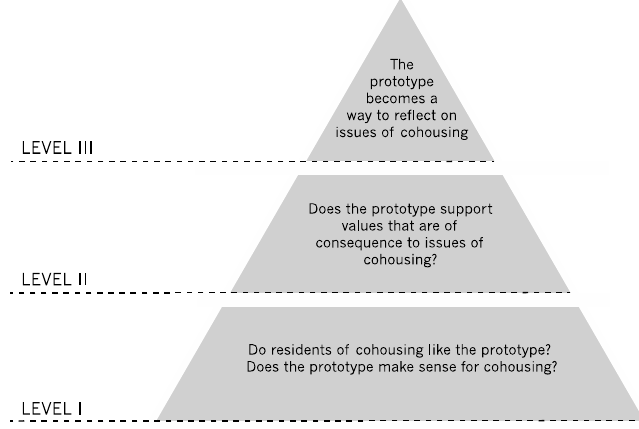
Figure 8. Three levels to consider the outcomes of the cohousing workshops with the prototypes.